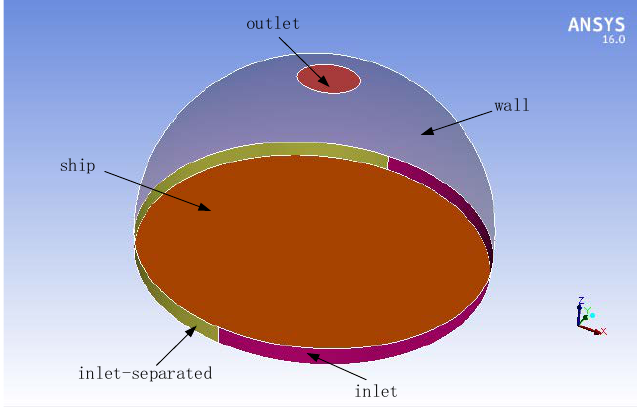
Figure 11. List display of boundary conditions in the basin. Table 2. Description of the corresponding type of each boundary in the mesh